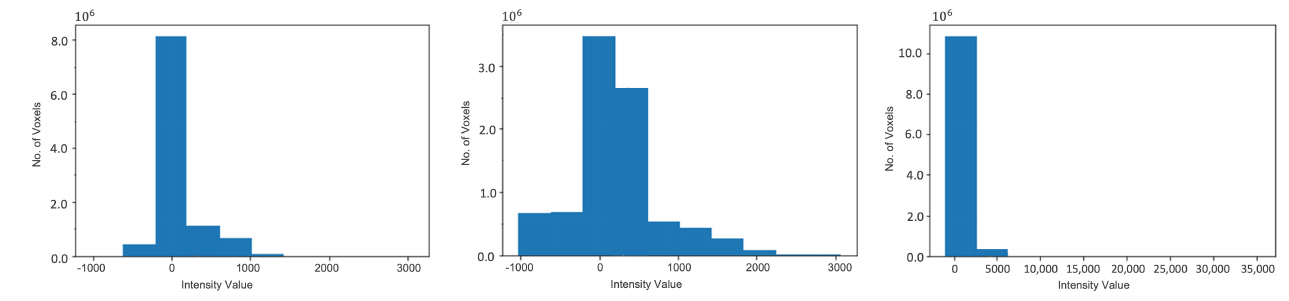
Figure 2. The intensity histograms of the different types of scans. WC represents the Window Centre calculated at run-time based on each